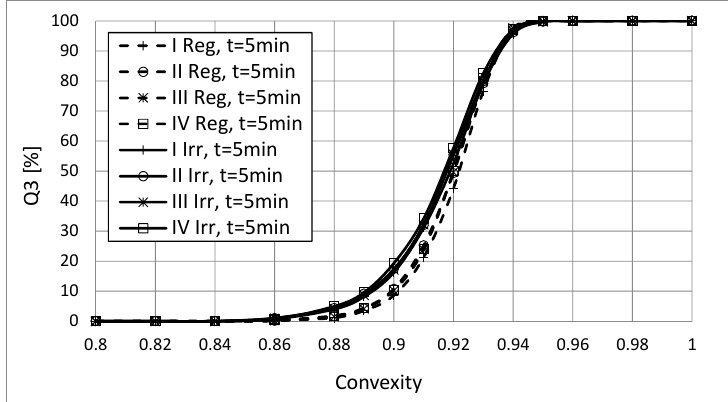
Figure 21. Comparison of Circularity distributions of chalcedonite enrichment products for regular and irregular particles.